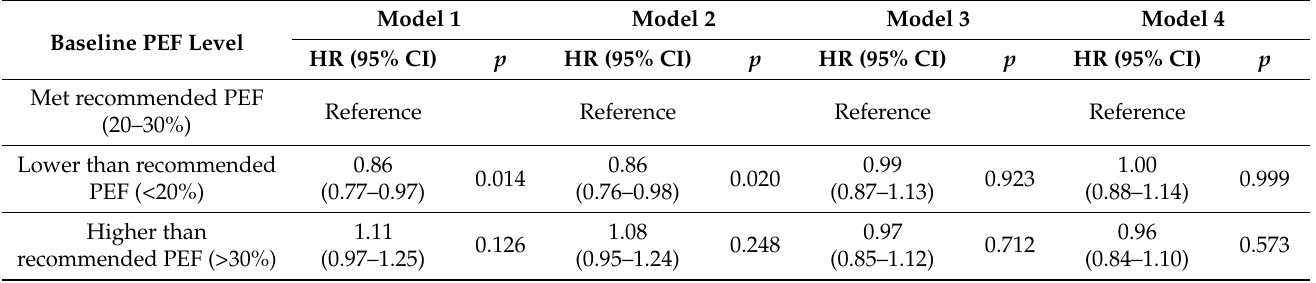
Table 2. The associations between percentage of energy from fat level at baseline and the risk of obesity: results of Cox proportional hazards regression models with shared frailty.